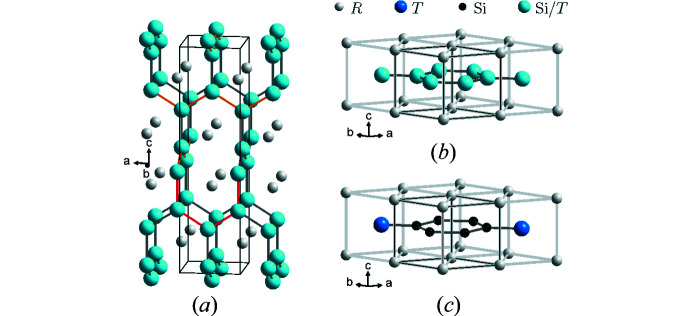
(a) Tetragonal ThSi2 and (b) hexagonal AlB2 structures of RSi2 and disordered as well as (c) ordered AlB2-like R
2
TSi3 compounds (unit cell outline in black). The AlB2 structures form a 2D sublattice of hexagonally arranged Si atoms (red bonds). In contrast, the ThSi2 structures form 3D networks with incomplete hexagons (red bonds), accompanied with the formation of zigzag chains alternately in a and b directions ab direction along the c stacking (orange bonds).